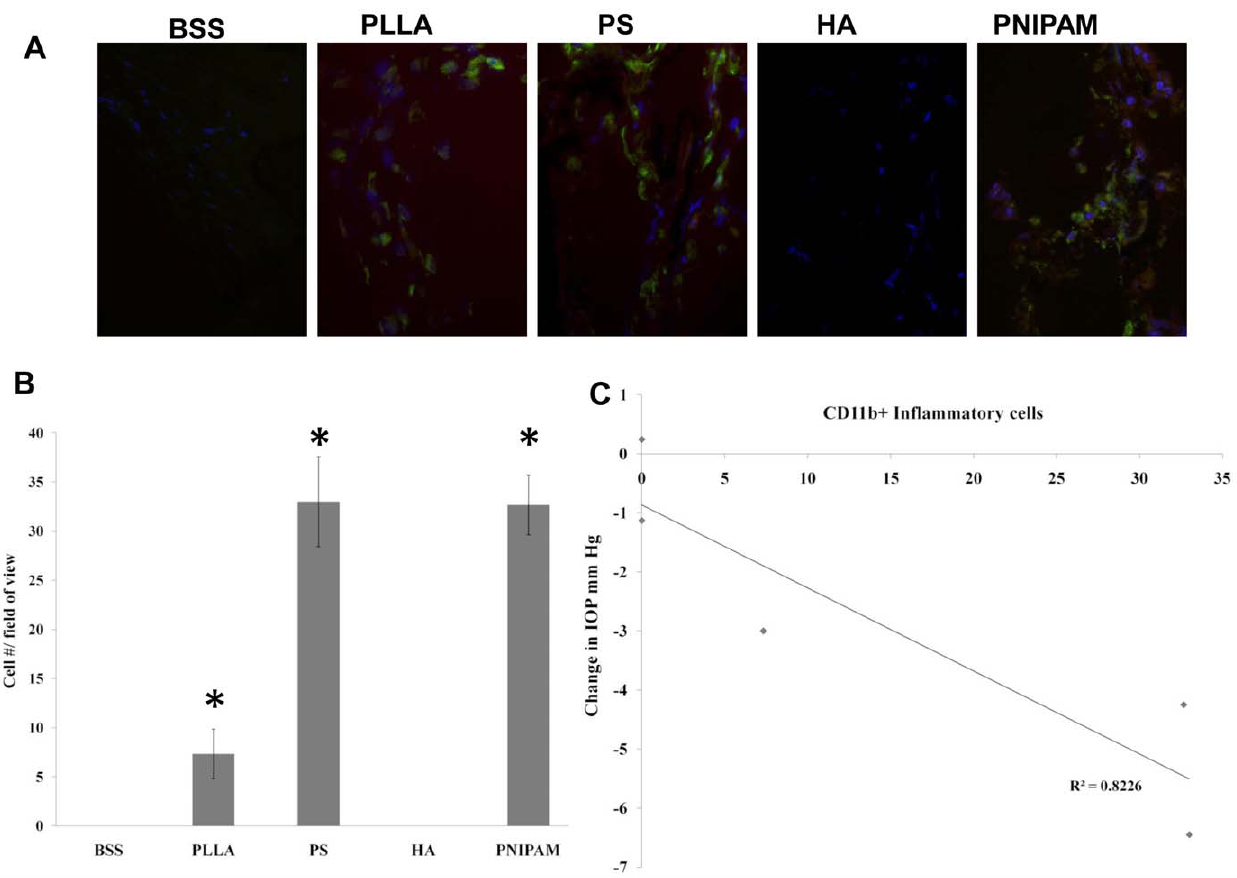
Figure 5. The accumulation of CD11b + inflammatory cells in the trabecular meshwork. The representative immunohistochemically stained images showed the accumulation of CD11b + inflammatory cells (labeled green; DAPI staining to locate cell nucleus) in the trabecular meshwork following particle injection (A). The extent of CD11b + cell accumulation in the trabecular meshwork was quantified (B). Data are mean 6 standard deviation. Significance of PLLA, PS, HA, PNIPAM vs. BSS control; * p , 0.05 Correlation between CD11b + inflammatory cells and average IOP changes in different test groups was also determined (C).